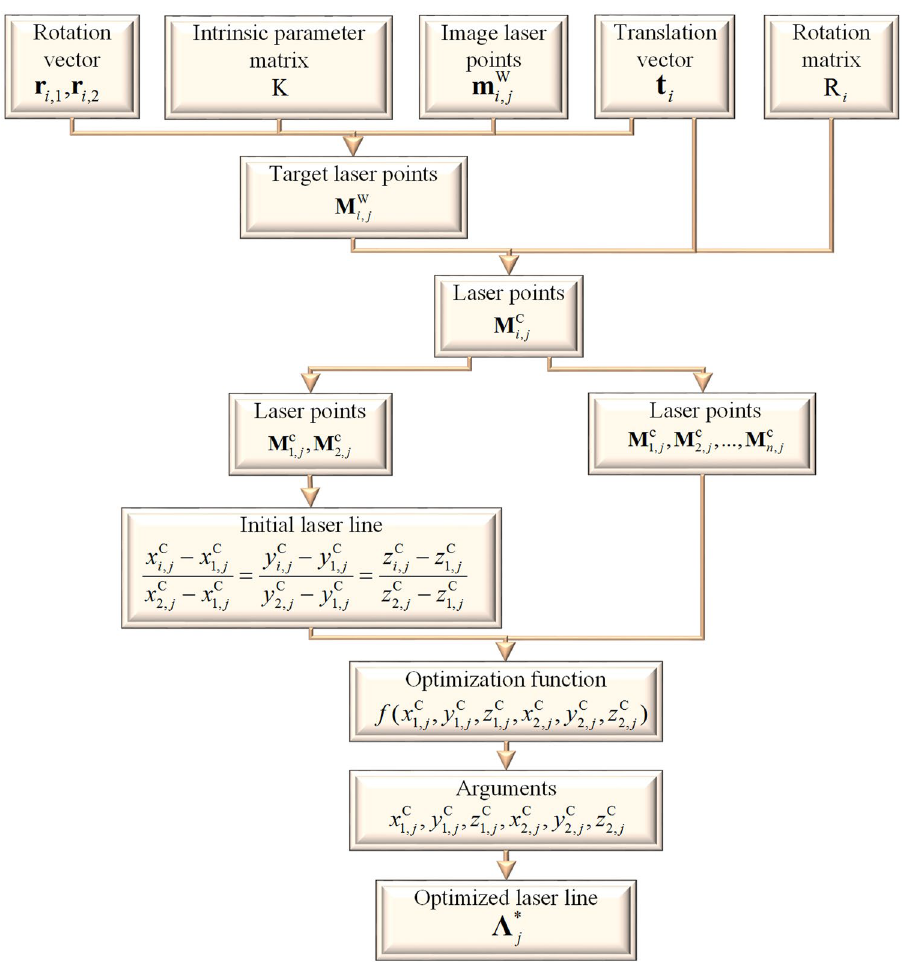
Figure 2. The solution process of the optimized laser line that is derived from the intersection laser points.